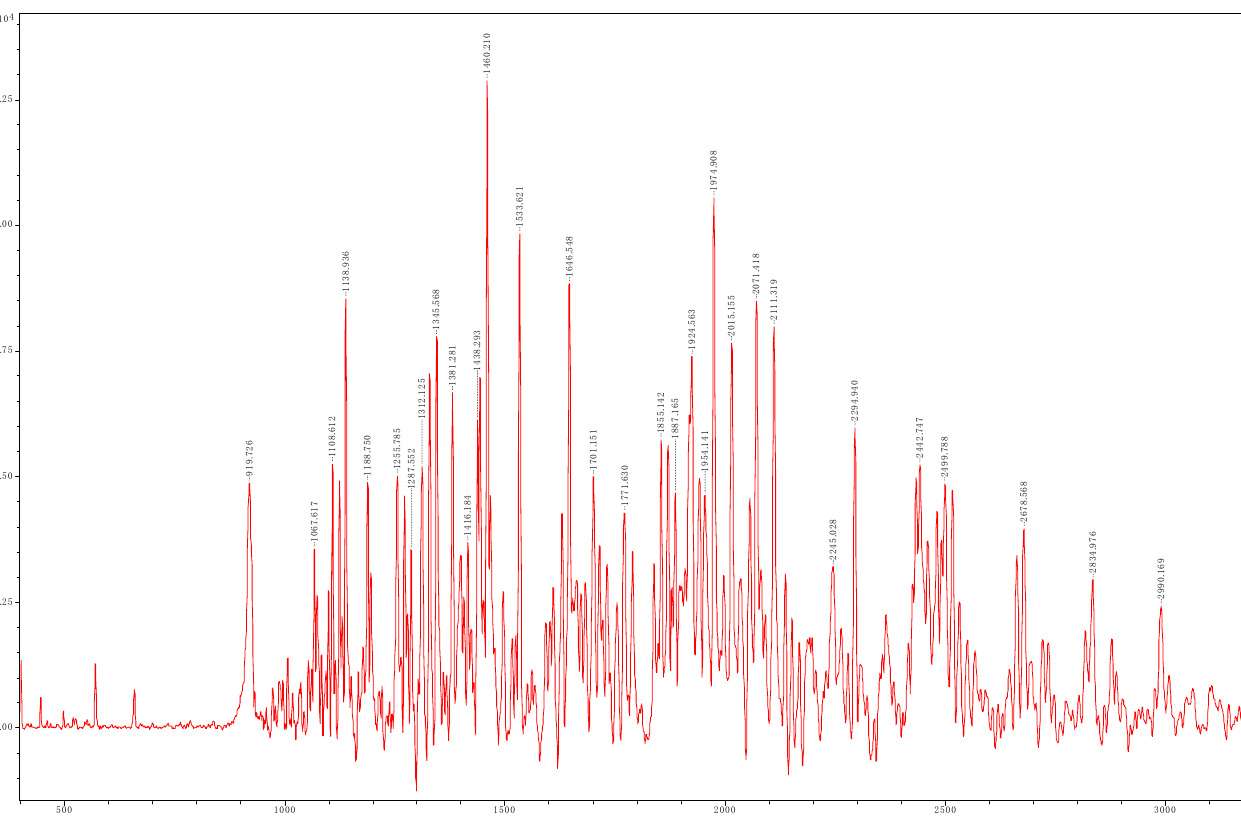
Figure 3. Size distribution of HC powder defatted using DSCS for 9 cycles, followed by washing using isopropanol for 2 cycles determined by MALDI-TOF mass spectrometry.